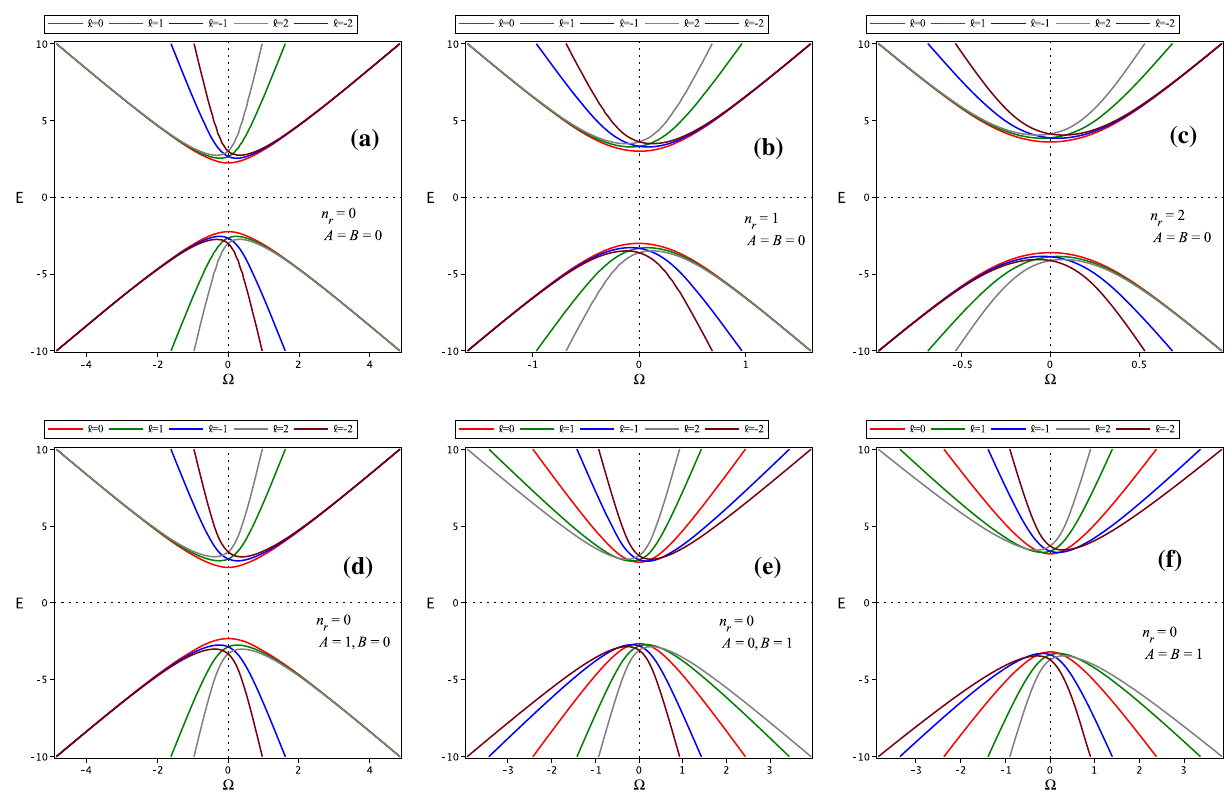
Fig. 1 For η = m = 1 we show E n n r = 0 , 1 , 2, respectively. In d – f we show the parametric effects of the of (23) against the vortic- r ,(cid:13) ity parameter (cid:2) and for (cid:13) = 0 , ± 1 , ± 2. In a – c we show the KG- Cornell confinement (14) on the KG-oscillator energies with n r = 0 for ( A = 1 , B = 0 ) , ( A = 0 , B = 1 ) , and ( A = 1 , B = 1 ) , oscillator energies without the confinement (i.e., A = B = 0) for